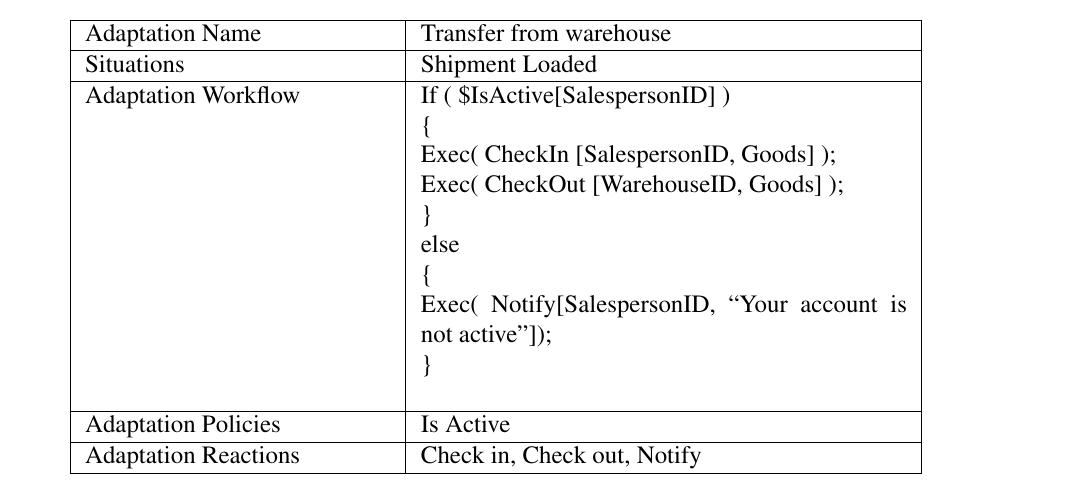
Table 3. Transfer from warehouse